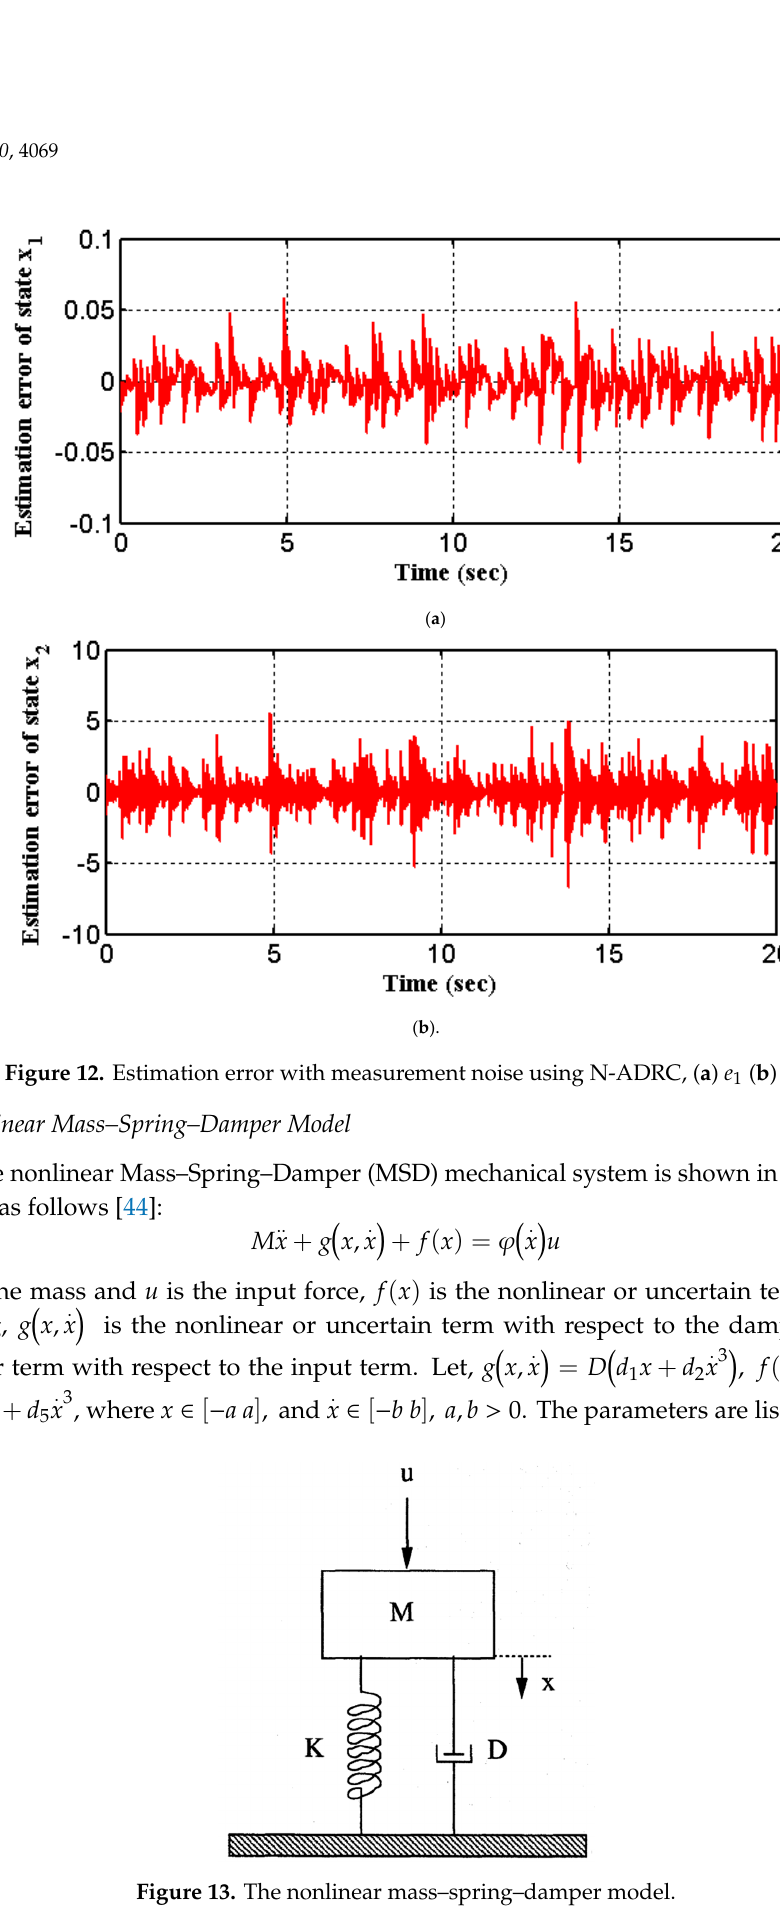
Figure 11. Estimation error without measurement noise using N-ADRC, ( a ) (cid:1857) (cid:2869) ( b ) (cid:1857) (cid:2870) .